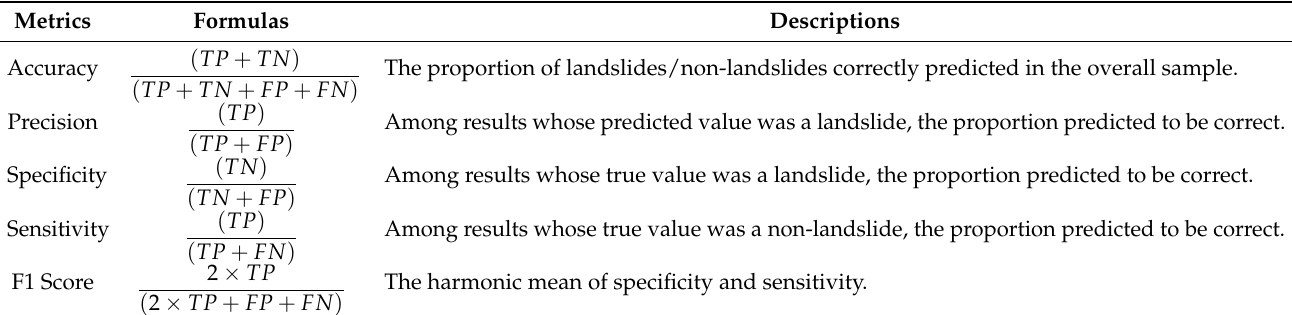
Table 3. Detailed information of evaluation